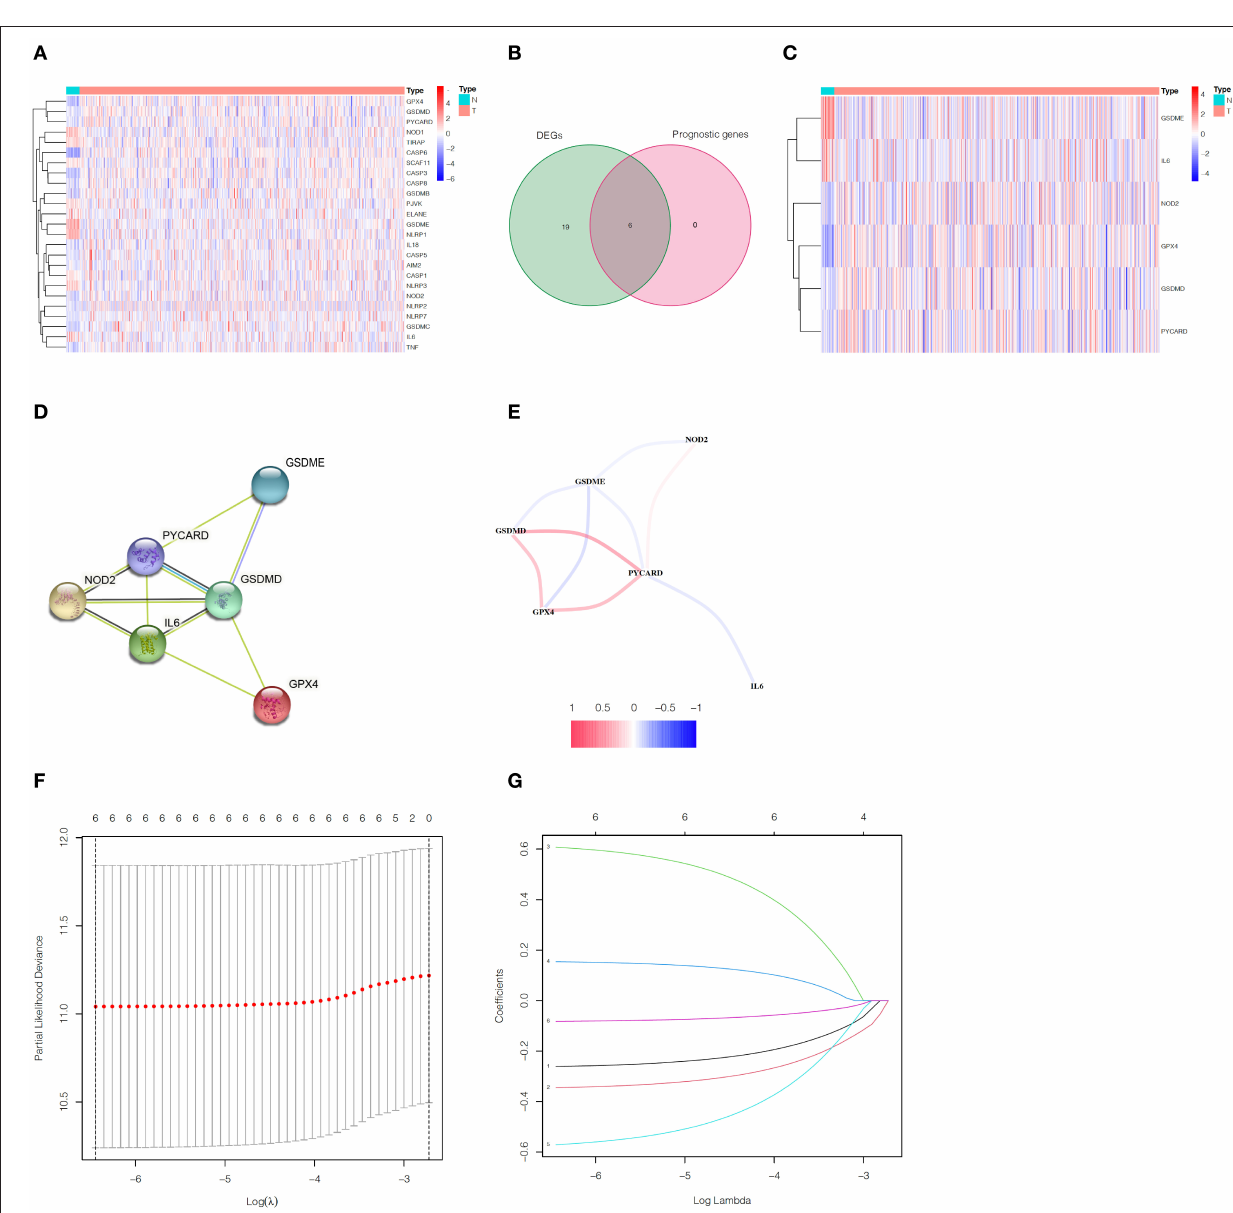
infiltrating cells and immune function in the TCGA training set and validation set. Hereafter, we utilized the “limma” package to analyze the difference of the scores between the two